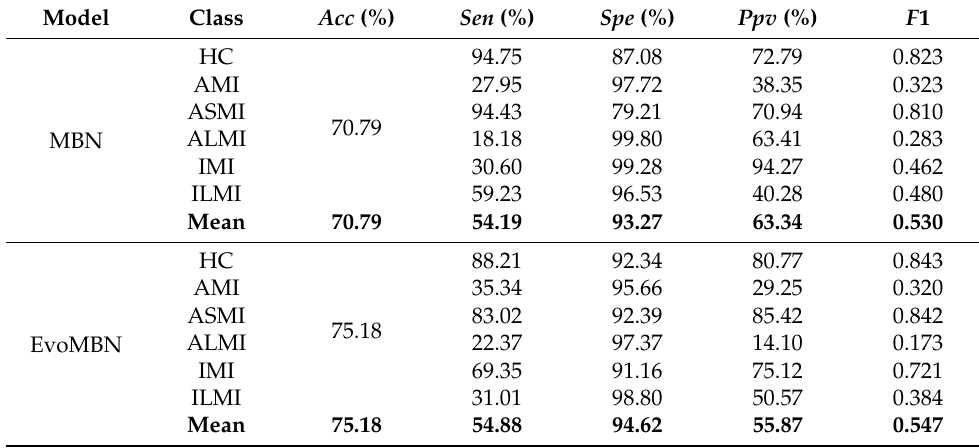
Table 6. The MI localization results on the PTB-XL database.